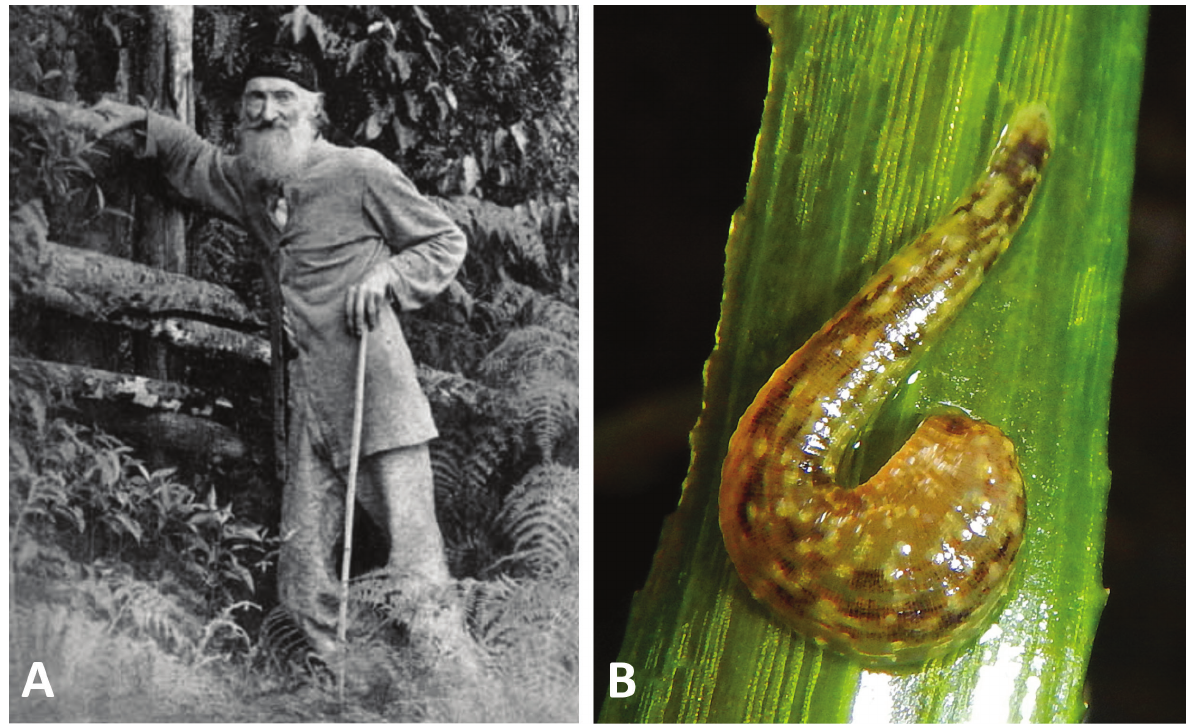
Figure 1. A: The naturalist Fritz Müller in his typical appearance. B: Live specimen of Glossiphonia verrucata collected in the Krakower Lake (Germany) in